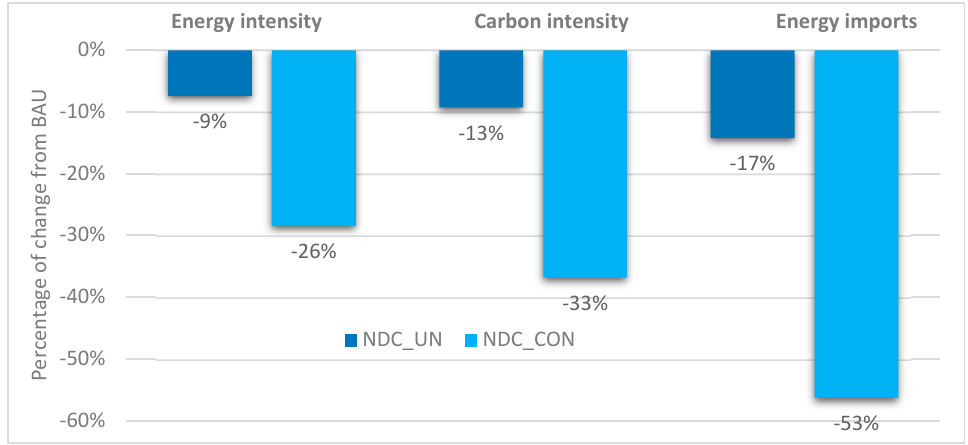
Figure 9. Key energy systems and emission indicators of Tunisia in 2030. Source: MENA-EDS Model.